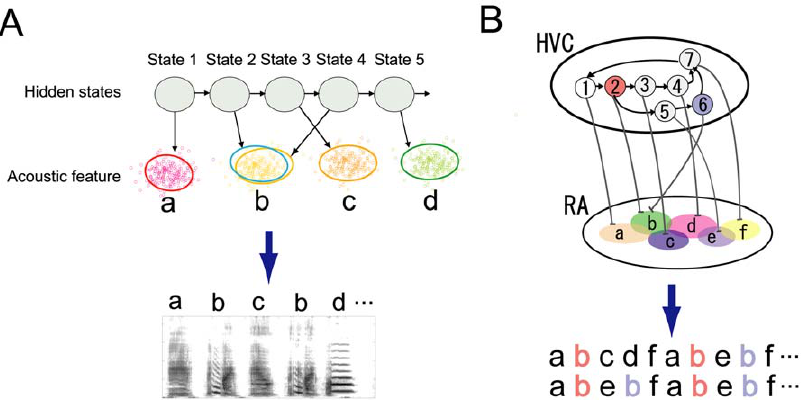
Figure 4. Schematic diagram representing how first-order HMM generates sequences that have higher-order context dependency and its neural implementation. (A) key point is that different states (States 2 and 4) can generate similar acoustic feature space (‘‘b’’). This mechanism allows observed song sequences to have higher-order context dependency, even if hidden state sequences are generated from simple Markov process. (B) Schematic of proposed model for neural implementation of Bengalese finch song syntax. Each circle in HVC represents neuron group consisting of feedforward chain of RA-projection neurons. Each group in HVC plays role in generating particular syllables through neuron group in RA. Groups 2 and 6 in HVC project to same RA neuron group that generates song syllable ‘‘b’’, as do States 2 and 4 in (A).